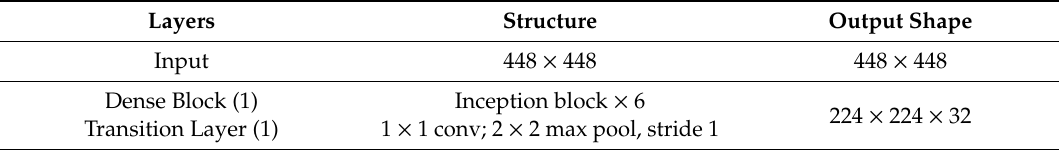
Table 2. Our improved Sing Shot multi-box Detector (SSD) architecture.